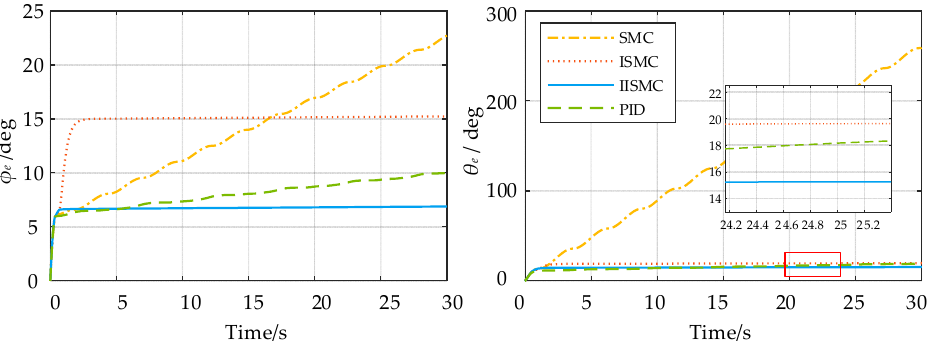
Figure 17. Cumulative attitude angles error under four control methods in Scene 4.